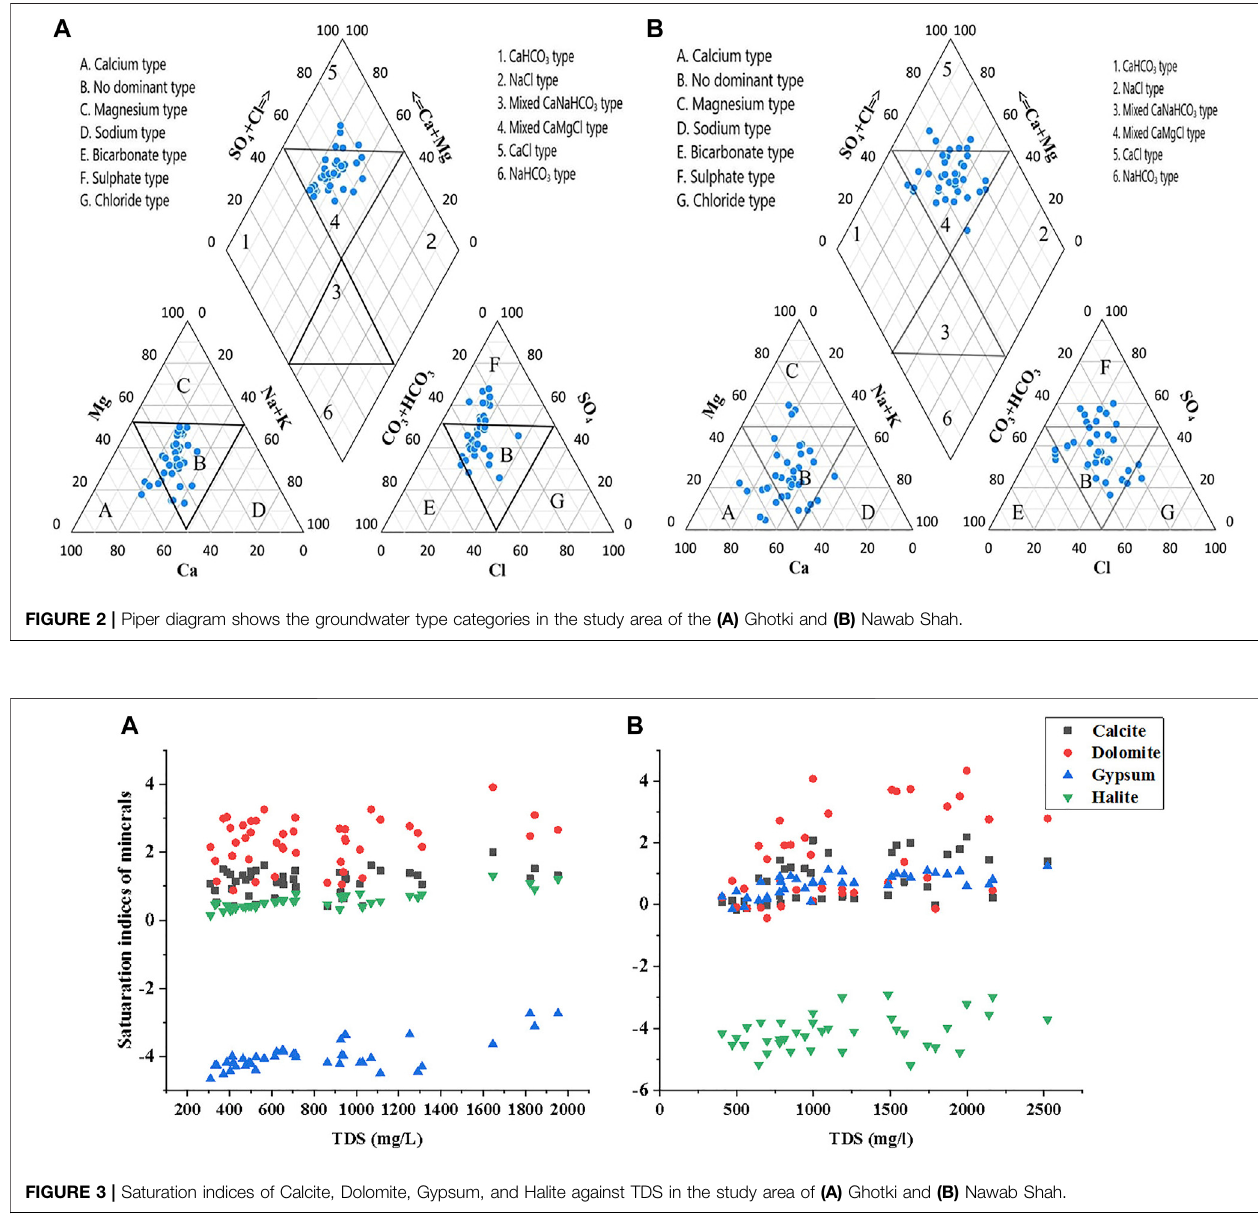
Frontiers in Environmental Science |